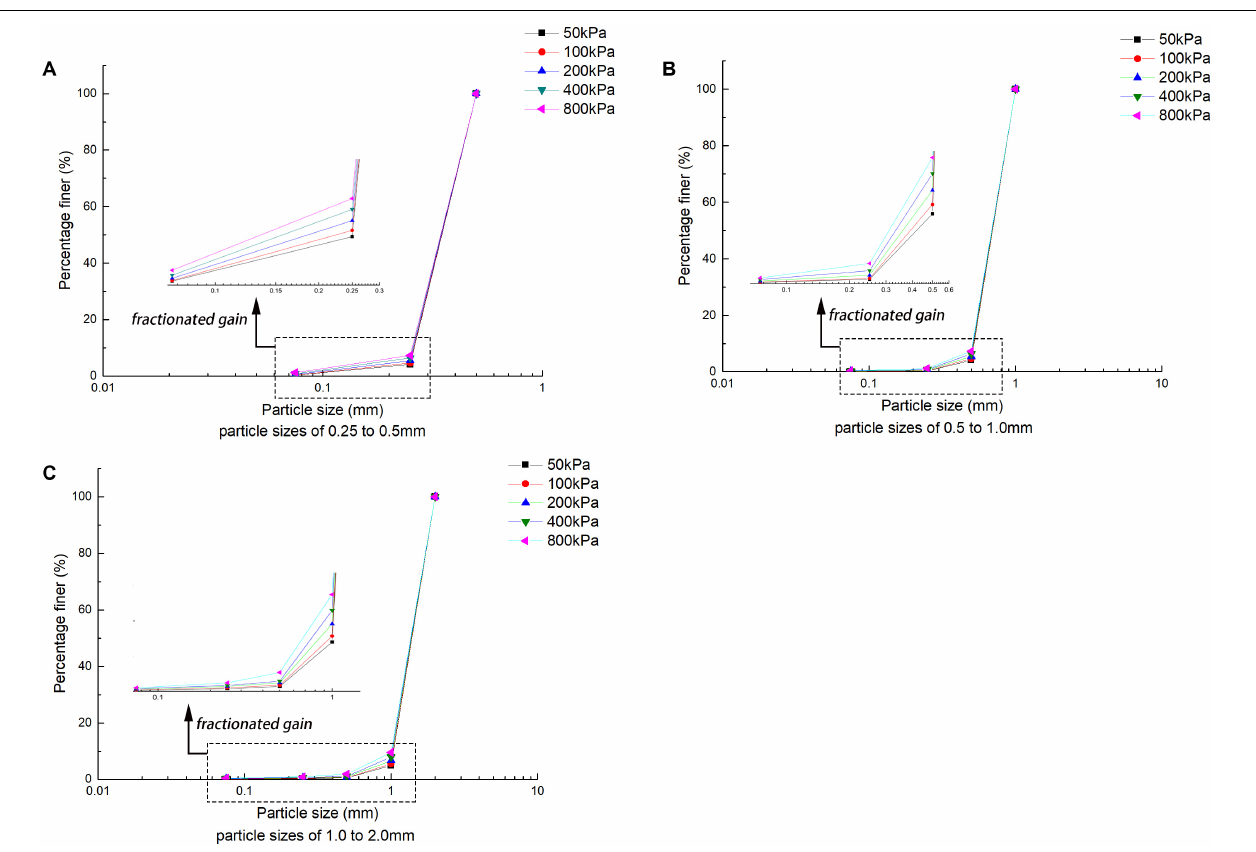
FIGURE 7 | Evolution of coral sand PSD (semi-logarithmic axes). (A) Particle sizes of 0.25–0.5 mm, (B) particle sizes of 0.5–1.0 mm, and (C) particle sizes of 1.0–2.0 mm.